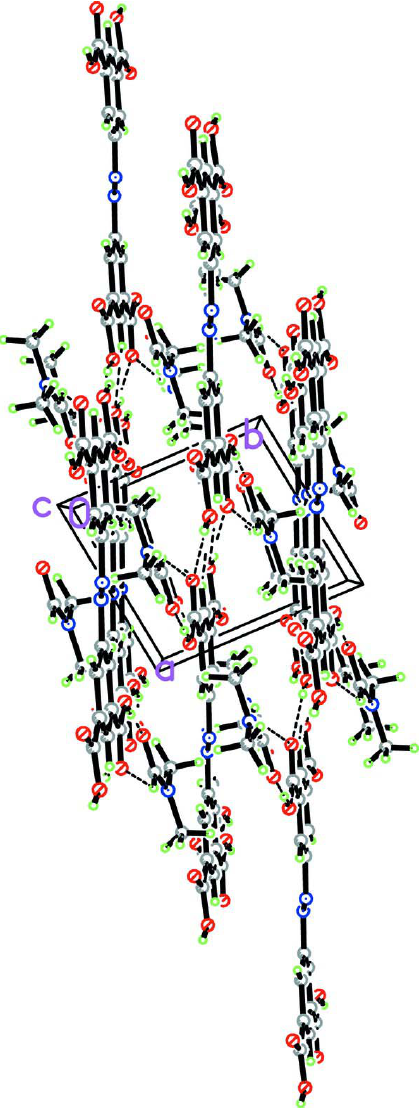
Packing diagram of the title compound, showing the structure along the c axis. Intermolecular hydrogen bonds are shown as dashed